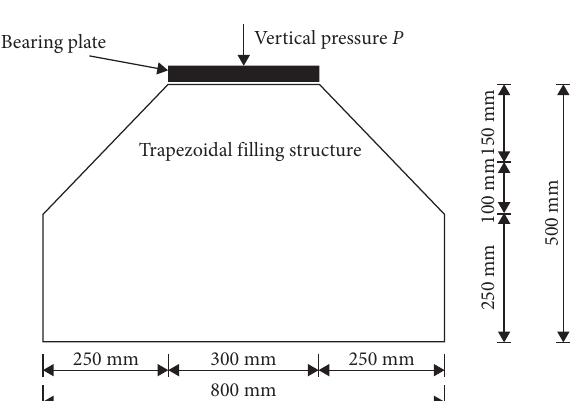
Figure 4: Diagram of trapezoidal filling structure.